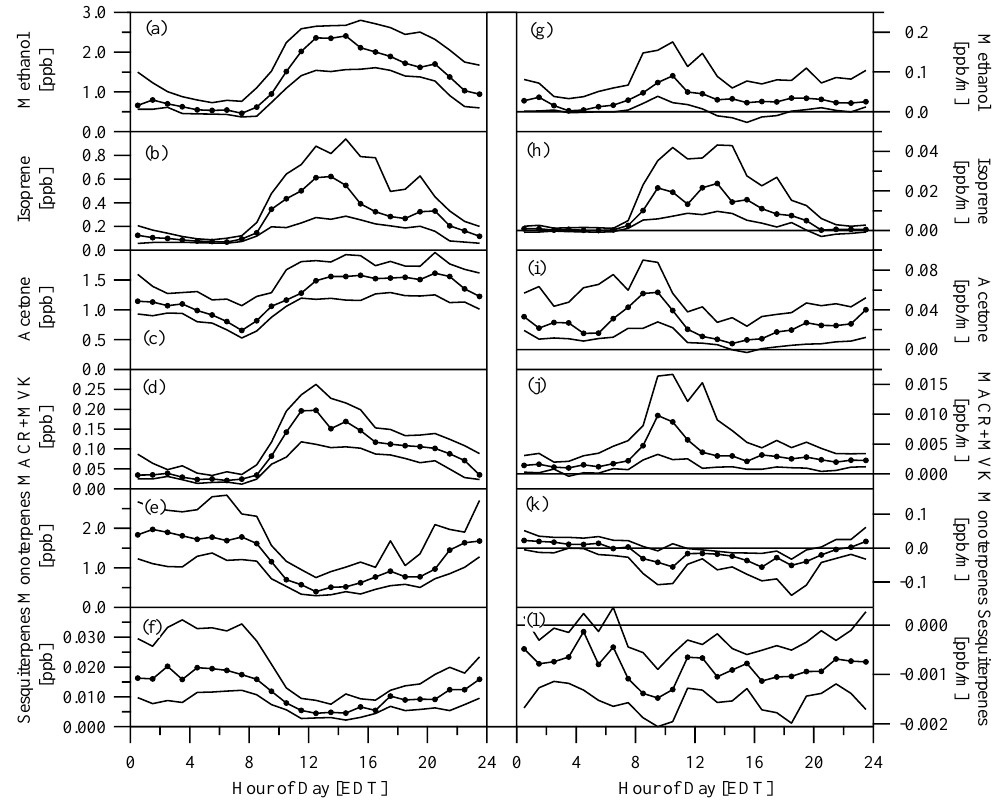
Figure 2. Hourly medians and quartiles of VOC mixing ratios (a–f) and slopes (g–l) over the 22 day measurement period (after filtering for wind direction). Mixing ratios [ppb] are at the 2m level and slopes [ppbm − 1 ] are determined as a least-squares fit between 1 and 6m. Sesquiterpene mixing ratio and slope (f, l) are not calibrated and are presented as relative units